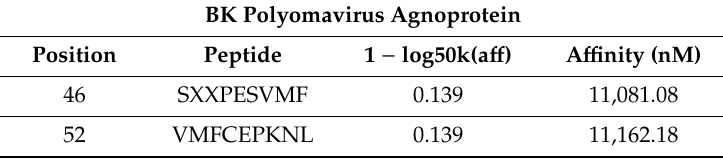
Table 5. High and moderate a ffi nity peptide sequences derived from BKPyV agnoprotein that may be presented by the HLA-E*01:01 allelic variations as identified by the machine-learning bioinformatics algorithm NetMHC 4.0. Position: residue number (starting from 0); peptide: amino acid sequence of the potential